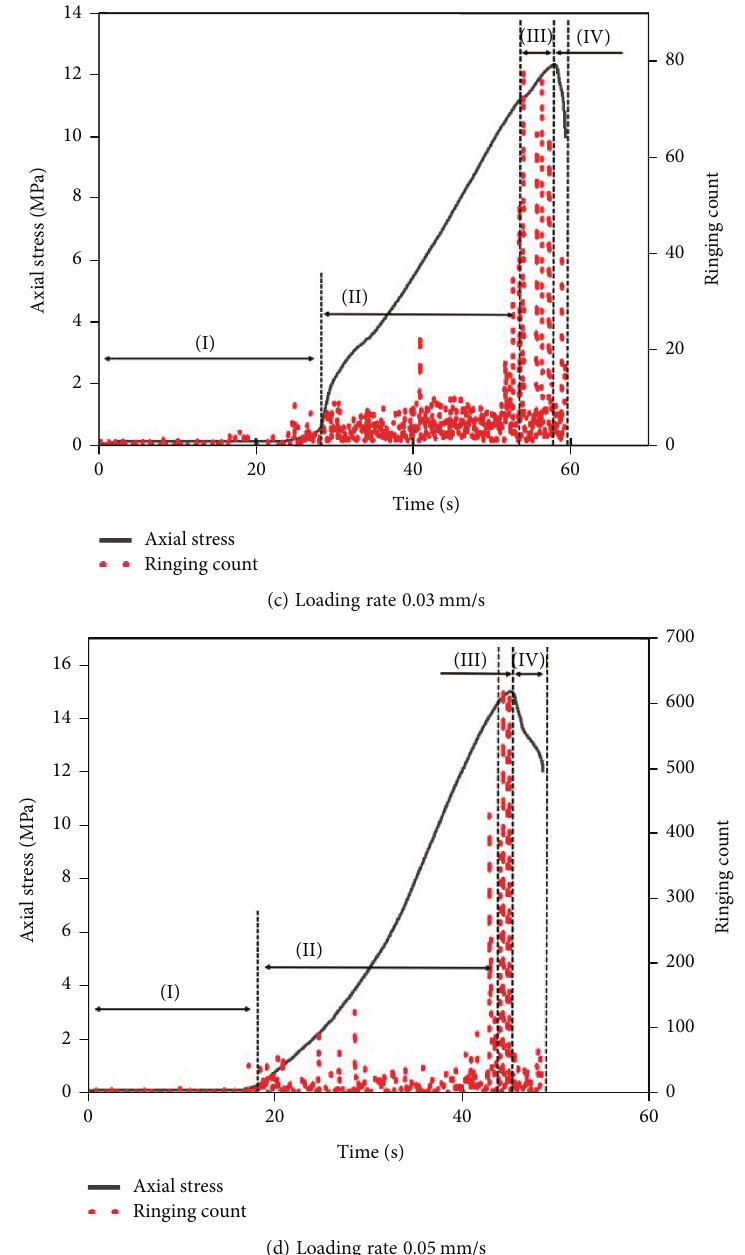
Figure 13: Stress and ring count curves with time during uniaxial compression of specimens with the fi ssure inclination angle 45 ° under di ff erent loading